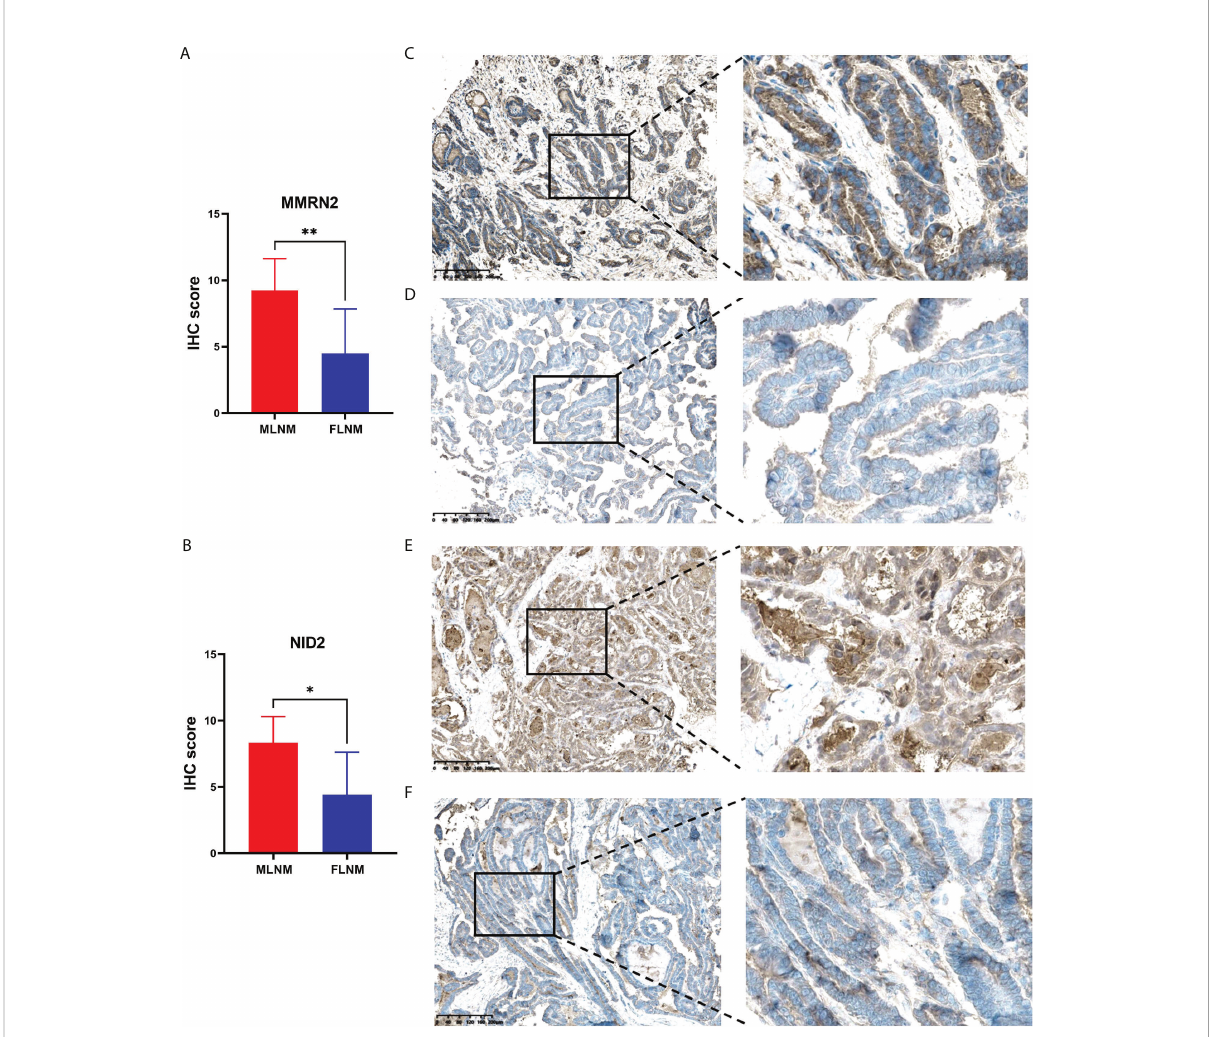
FIGURE 5 Validation of the differential expression of MMRN2 and NID2 between MLNM and FLNM in another independent cohort. (A, B) MMRN2 and NID2 were signi fi cantly upregulated in MLNM tissues compared with FLNM tissues. IHC staining was assessed as the sum of the percentage and intensity scores. (*) P <0.05, (**) P <0.01. (C – F) Representative IHC staining of MMRN2 ( C , MLNM; D , FLNM) and NID2 ( E , MLNM; F , FLNM) in PTMC